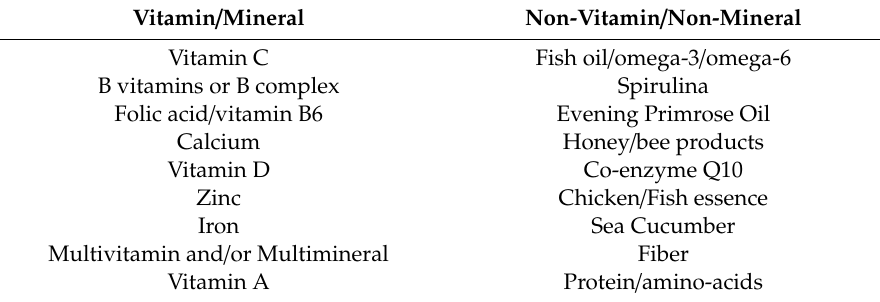
Table A1. Examples of VM and NVNM